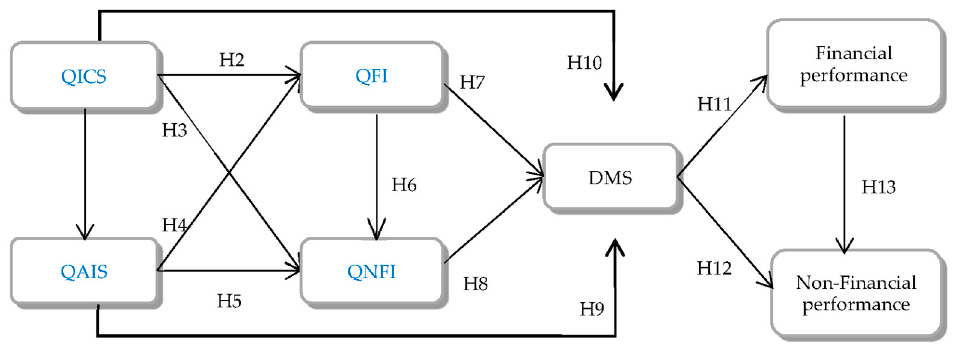
Figure 1. Conceptual model. Legend: QICS—Quality of ICS; QAIS—Quality of AIS; QFI—Quality of FI; QNFI—Quality of NFI.